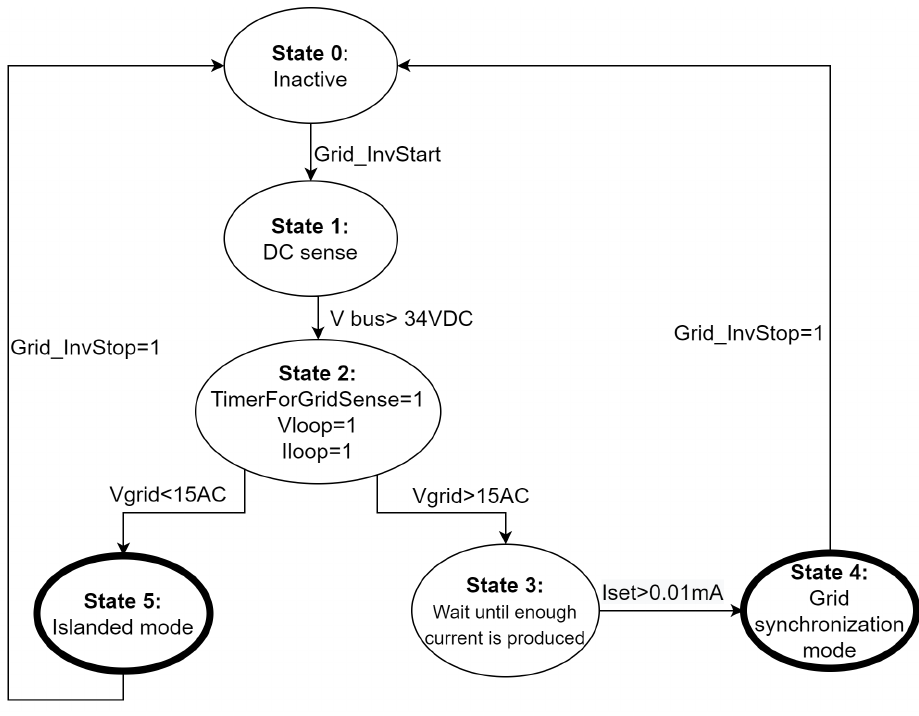
Figure 3. State machine of